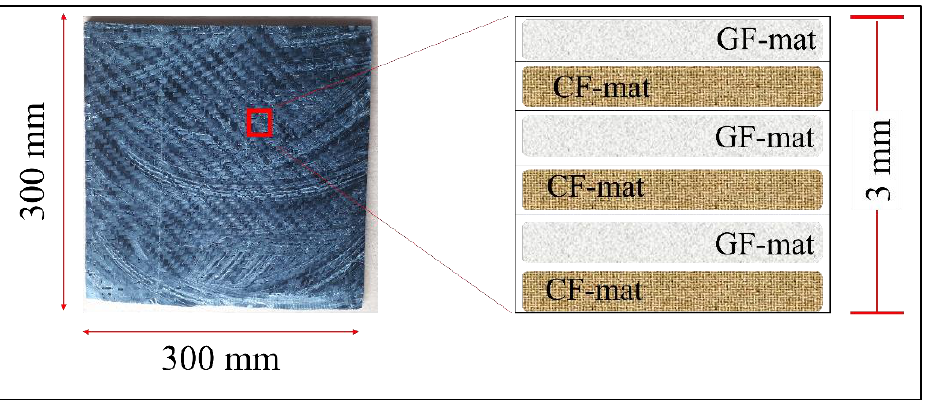
Figure 1. Schematic illustration of epoxy laminates reinforced with GF and CF mats with thickness of 3 mm. of 3